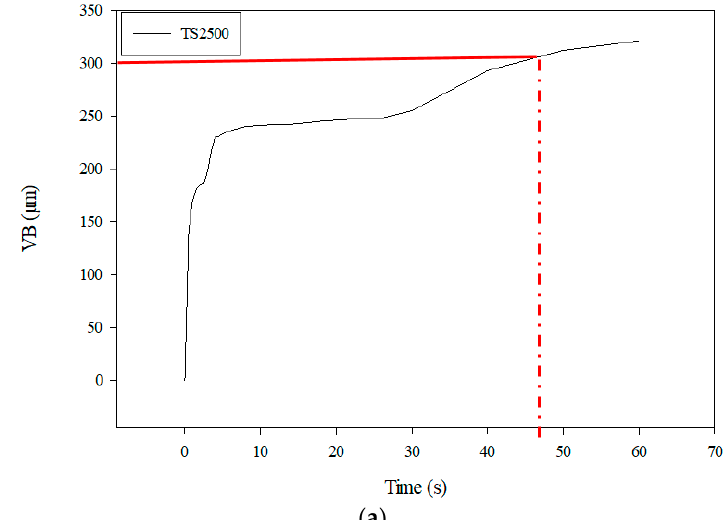
Figure 6. Flank wear (VB) profile for both inserts.